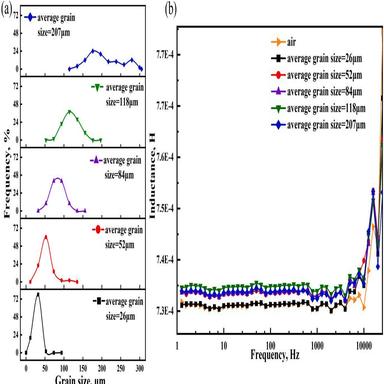
(a) Austenite grain size distribution for samples with different holding time, (b) frequency-inductance curves of ferrite and austenite dual-phase structure microstructure with different Phase fraction.